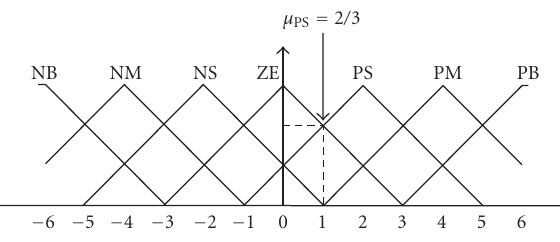
Figure 1: Block diagram of fuzzy controller.